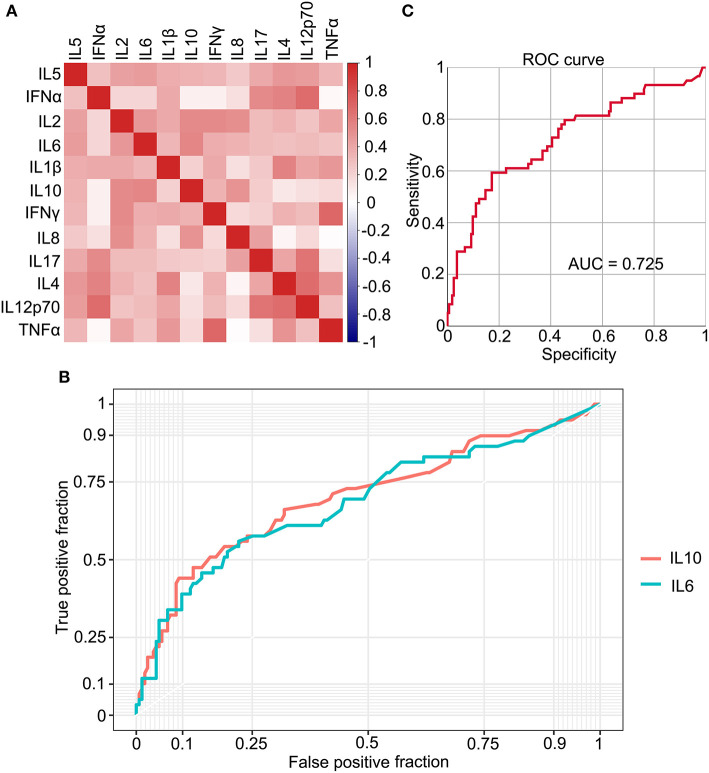
The relationship between IL-6 and multiple cytokines. (A) The correlation between 12 types of cytokines. (B) The receiver operating characteristic (ROC) curve plots IL-6 and IL-10, individually. (C) The ROC curve plots based on IL-6 and IL-10.